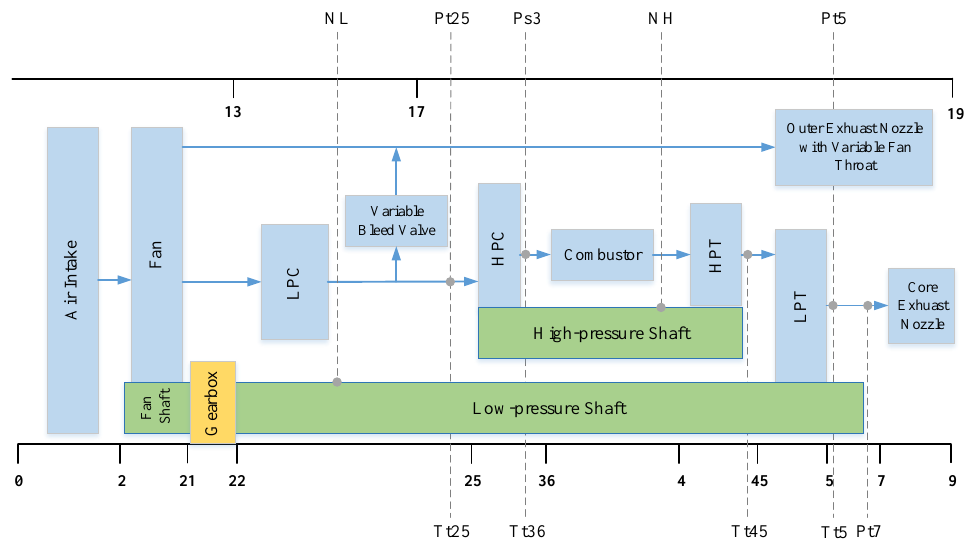
Figure 1. Schematic diagram of the engine structure and the position of the sensors used for detection. Abbreviations: low-pressure compressor (LPC), high-pressure compressor (HPC), high-pressure turbine (HPT), low-pressure turbine (LPT).